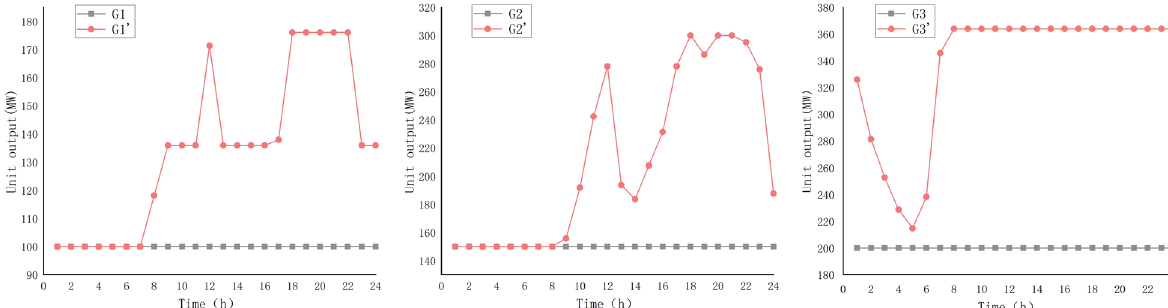
Fig. 11 Output for wind power units under Scenario 2 (G1, G2, and G3) and Scenario 1 (G1’, G2’, and G3’)